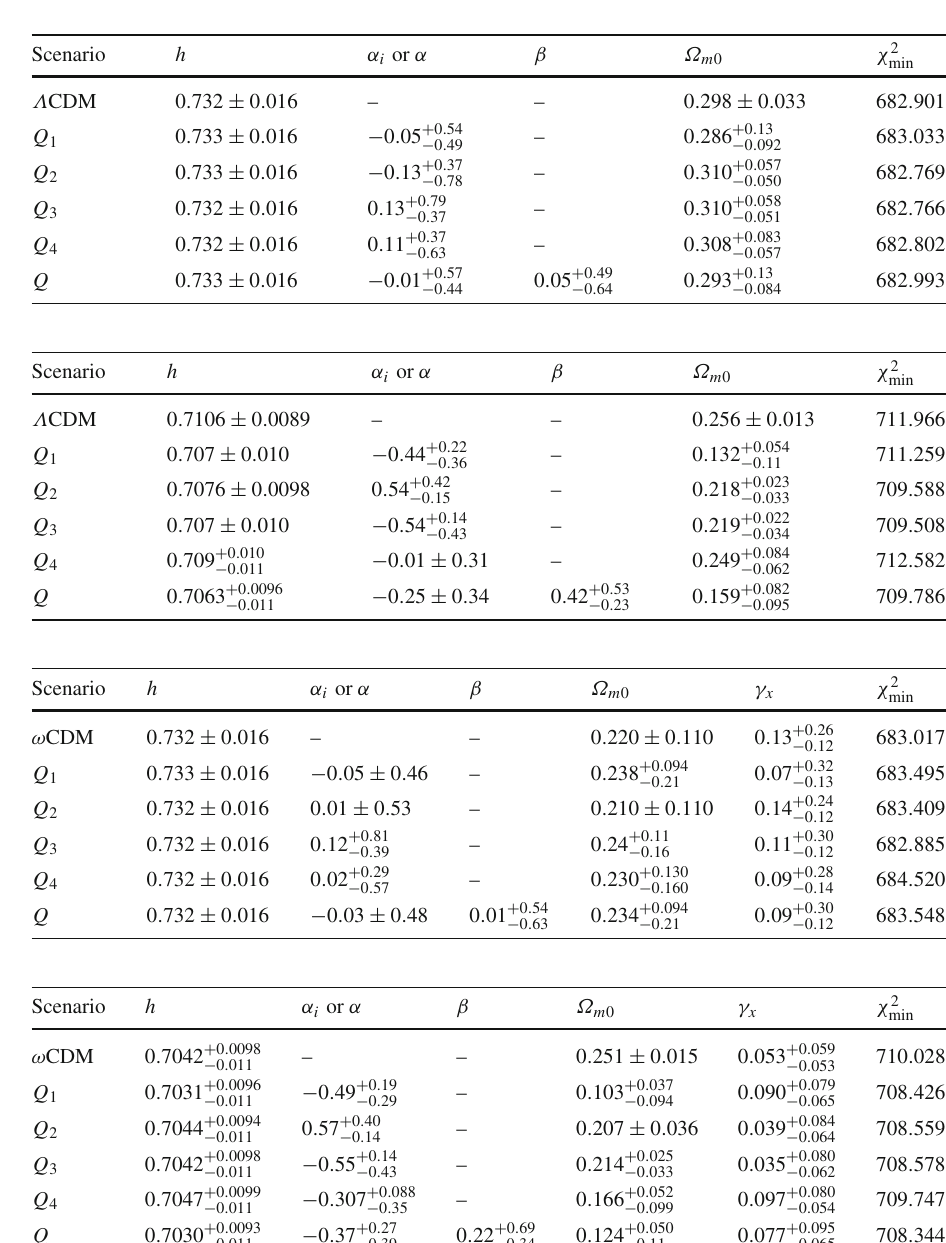
Table 2 Best fit parameters and 1 σ error for the analysis using JLA + H 0 . We have considered γ